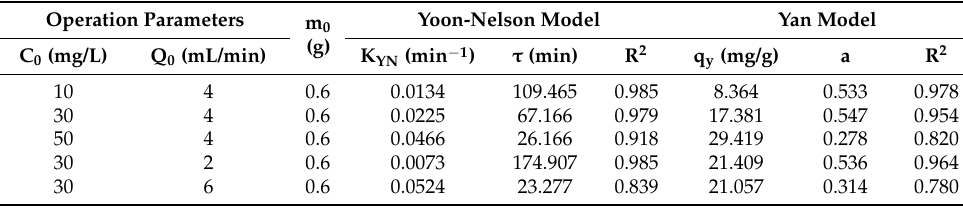
Table 2. Fitting results of Yoon–Nelson and Yan dynamic adsorption